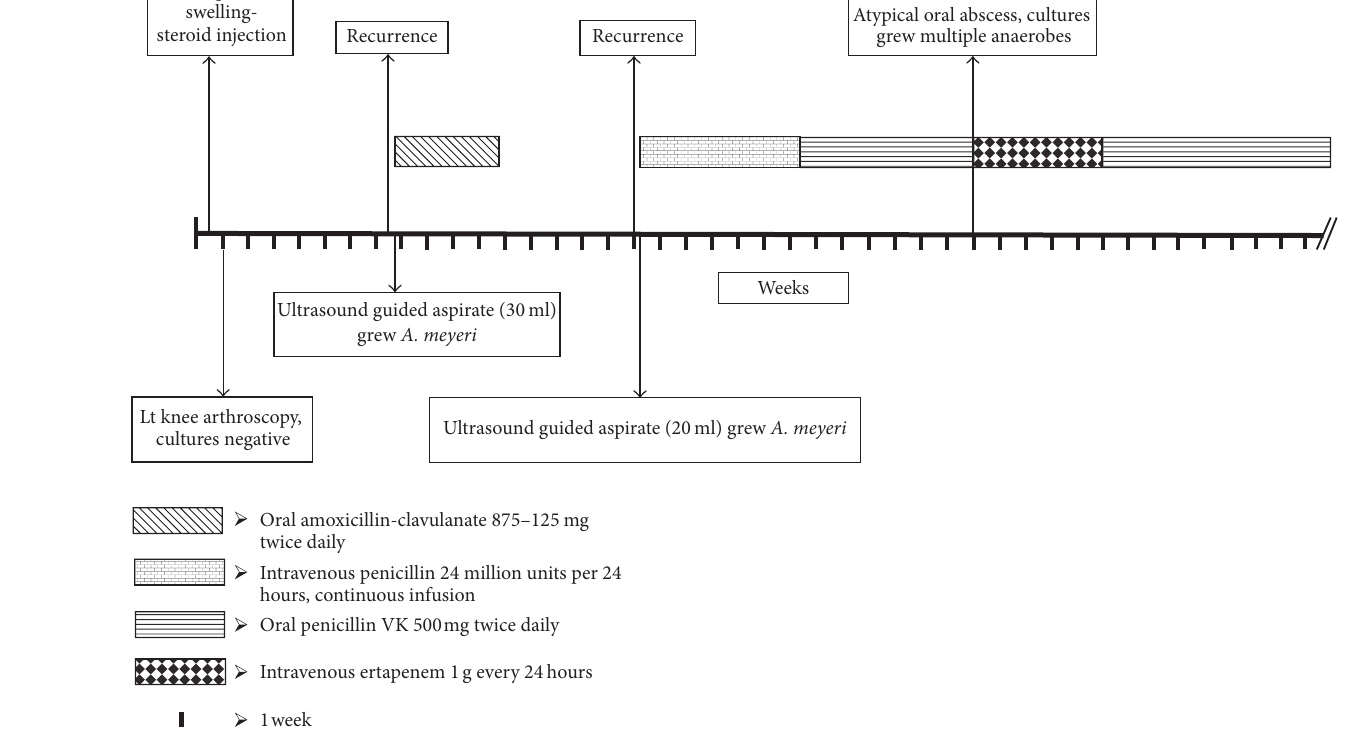
Figure 2: Timeline of clinical course and